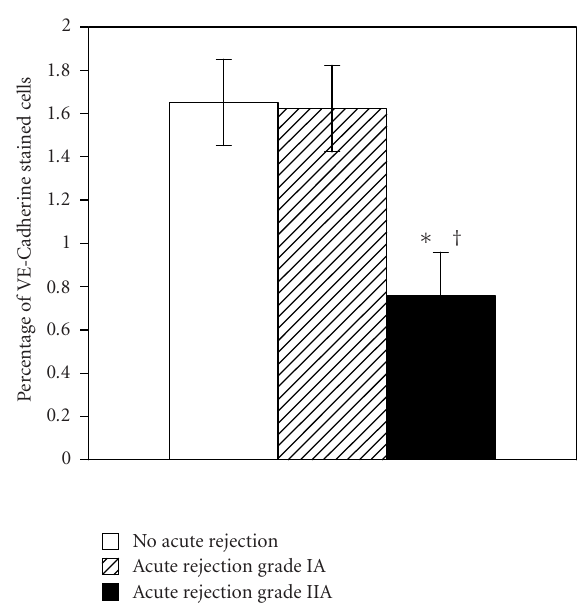
Figure 2: Immunohistochemical staining grade of VE-Cadherin on endothelial cells. ∗ P < . 05 acute rejection grade IIA versus acute rejection grade IA; † P < . 05 acute rejection grade IIA versus no acute rejection.